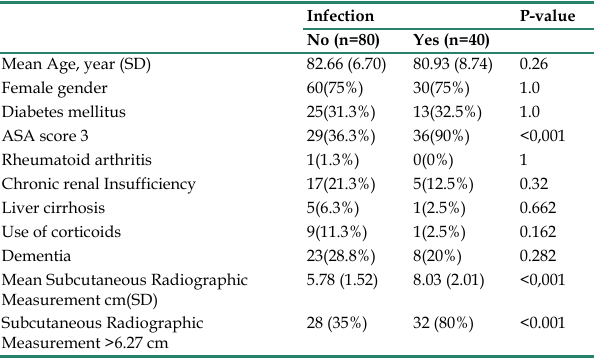
Table 1. Univariate analysis